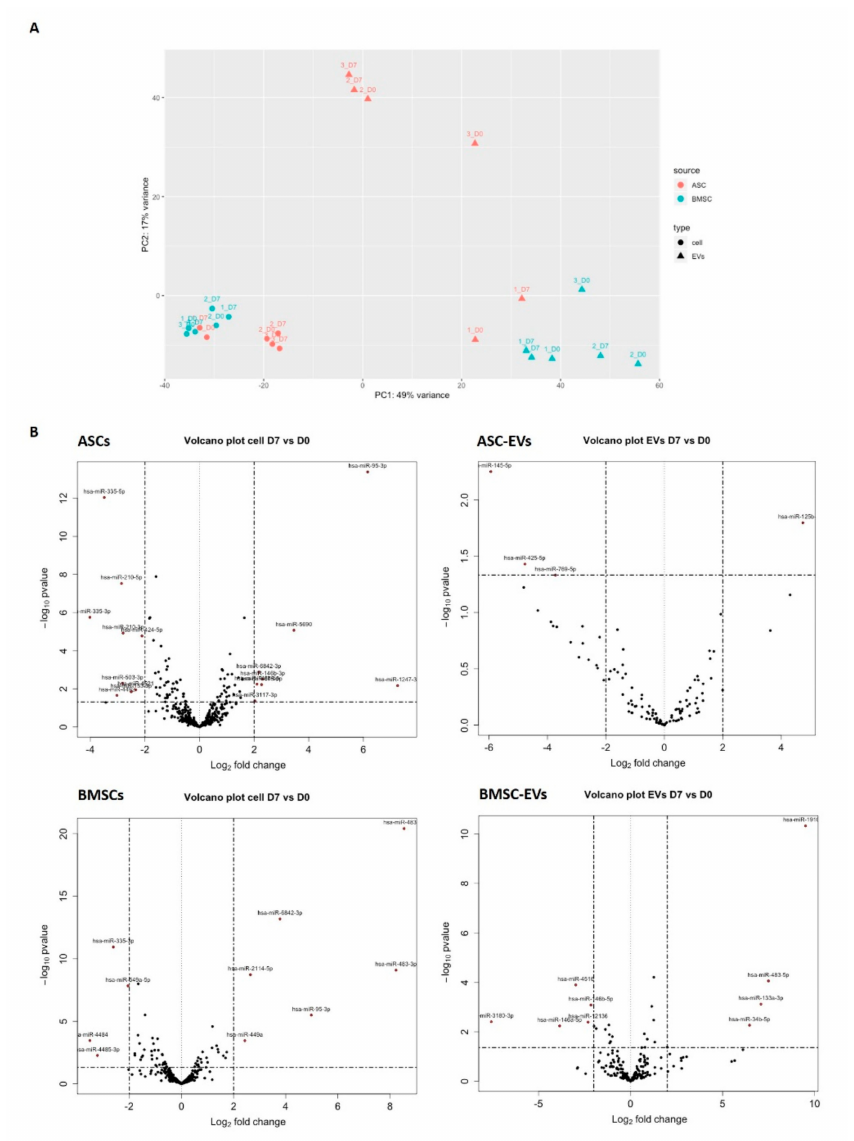
Figure 3. Di ff erential expression analysis of miRNAs in MSCs and MSC-EVs in osteoblastic di ff erentiation. ( A ) Principal component analysis ( PCA) analysis (filled circle, cells; triangles, EVs; red, ASC; green, BMSC; numbers, di ff erent cell donors); ( B ) Di ff erential expression analysis of miRNAs using DESeq2. The miRNAs with Abs (log2FoldChange) ≥ 2 and p value < 0.05 are deemed as significantly changed and marked in red in the volcano